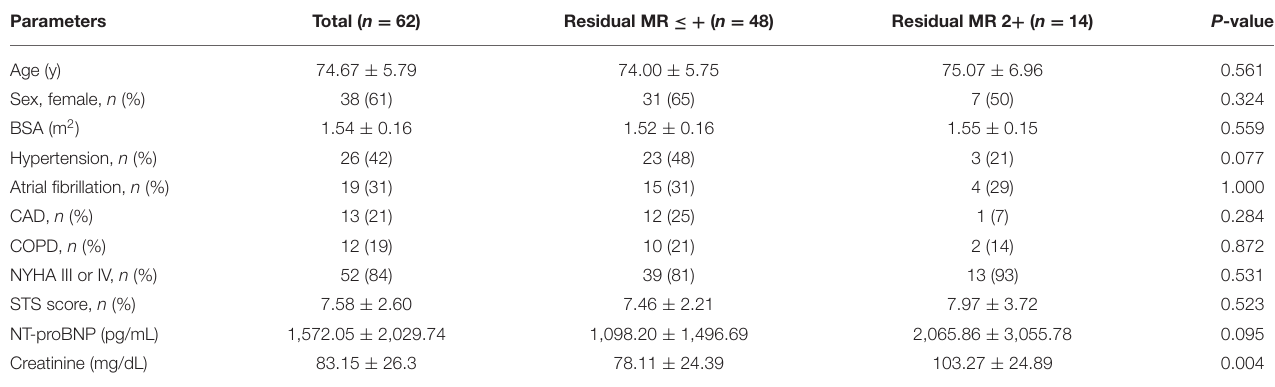
TABLE 1 | Baseline clinical